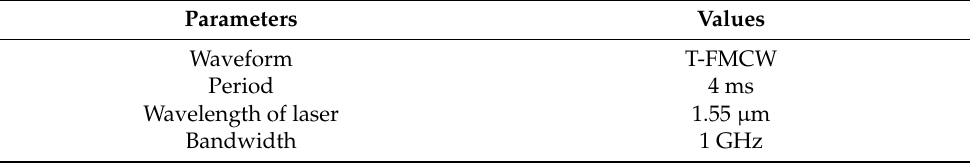
Table 1. Parameters of frequency modulation continuous wave (FMCW)